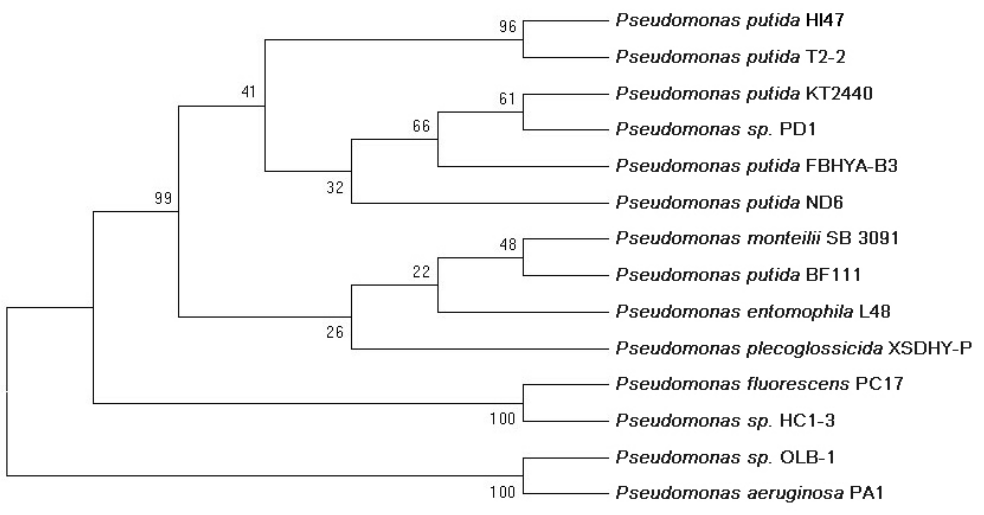
Figure 1. Time course of growth curve and PAM removal efficiency of P. putida HI47.